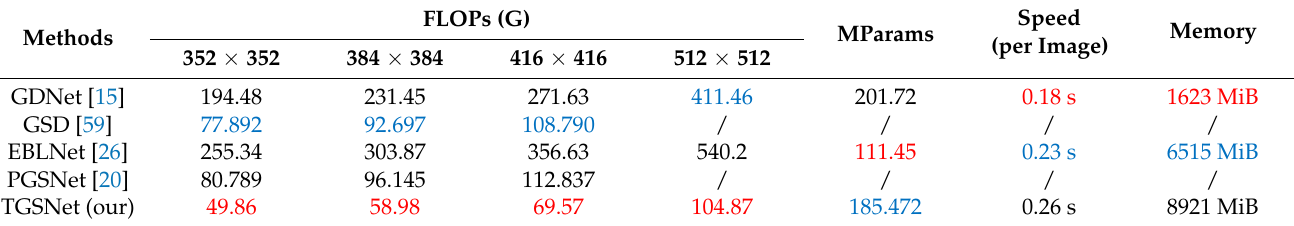
Table 3. Comparison results of our algorithm with state-of-the-art glass and transparent object segmentation methods in terms of computational efficiency as well as average inferred speed per image and memory usage. Red indicates the best results, and blue indicates the second-best results.